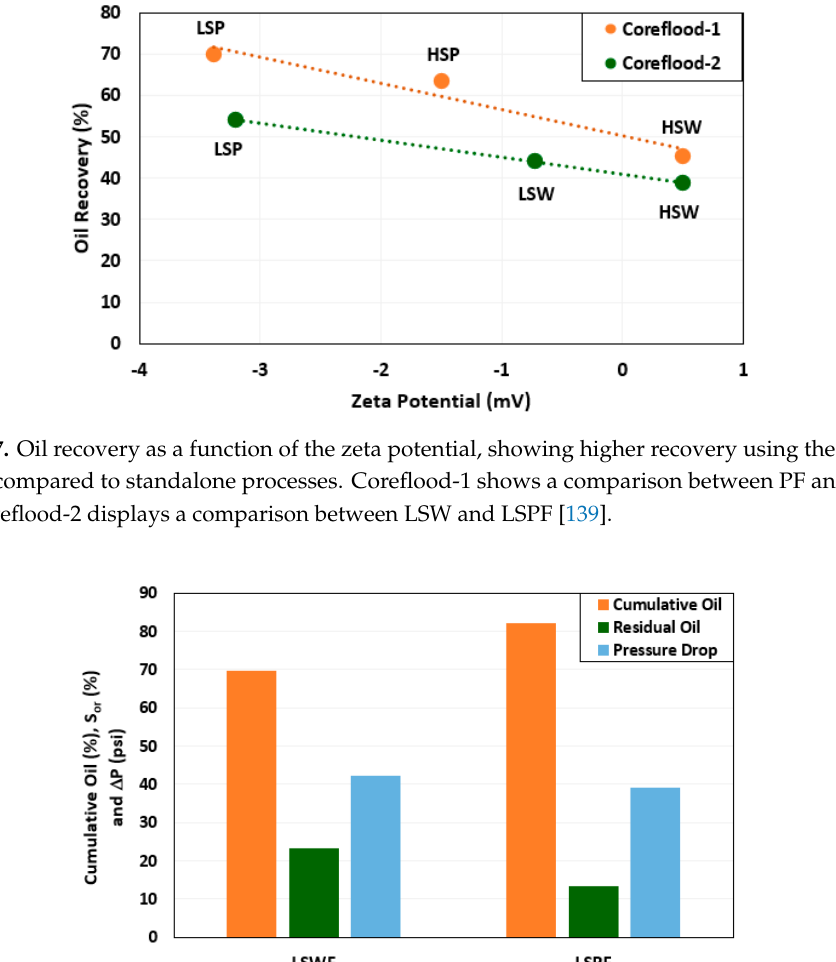
Figure 18. Comparison of oil recovery, S or , and pressure drop values using LSWF followed by LSPF in a Kuwaiti carbonate oil reservoir composite core [15].